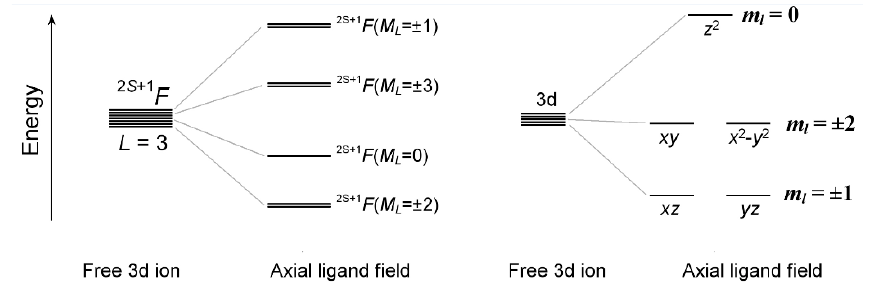
Figure 1. Energy splitting of the ground-state atomic term 2S+1 F ( L = 3) and 3d orbitals in a ligand field of axial symmetry. The orbital composition of the 2 S +1 F ( M L = ±3) states is shown below in the insets to the corresponding figures.